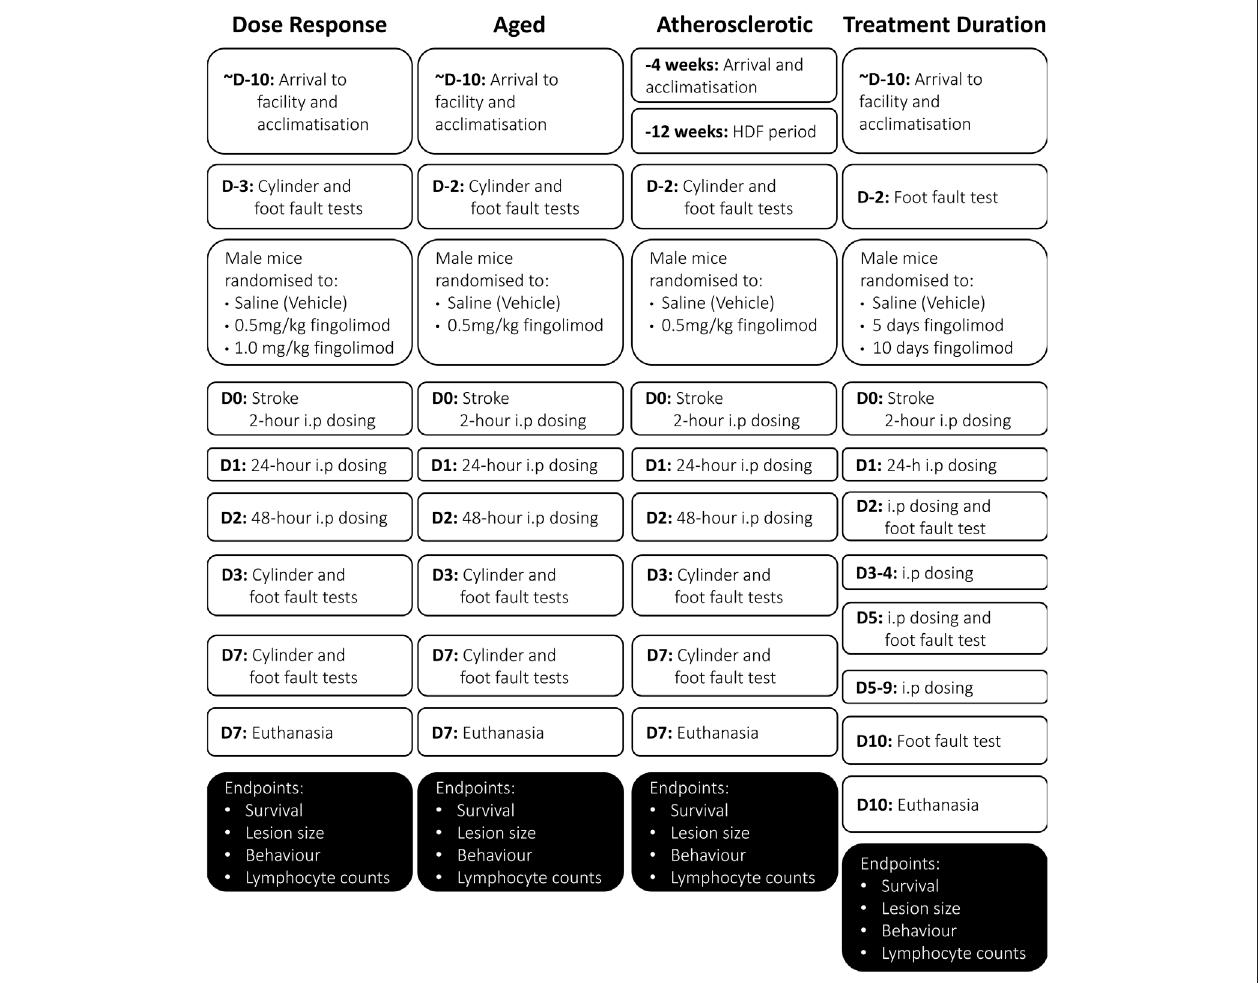
FIGURE 1 | Flowcharts illustrating the experimental design and timeline in the various sub-studies included in these studies (D, day; W, week). Note that the acclimatization period was at least 10-days for all mice, and may have been as much as 2-weeks long for some mice.